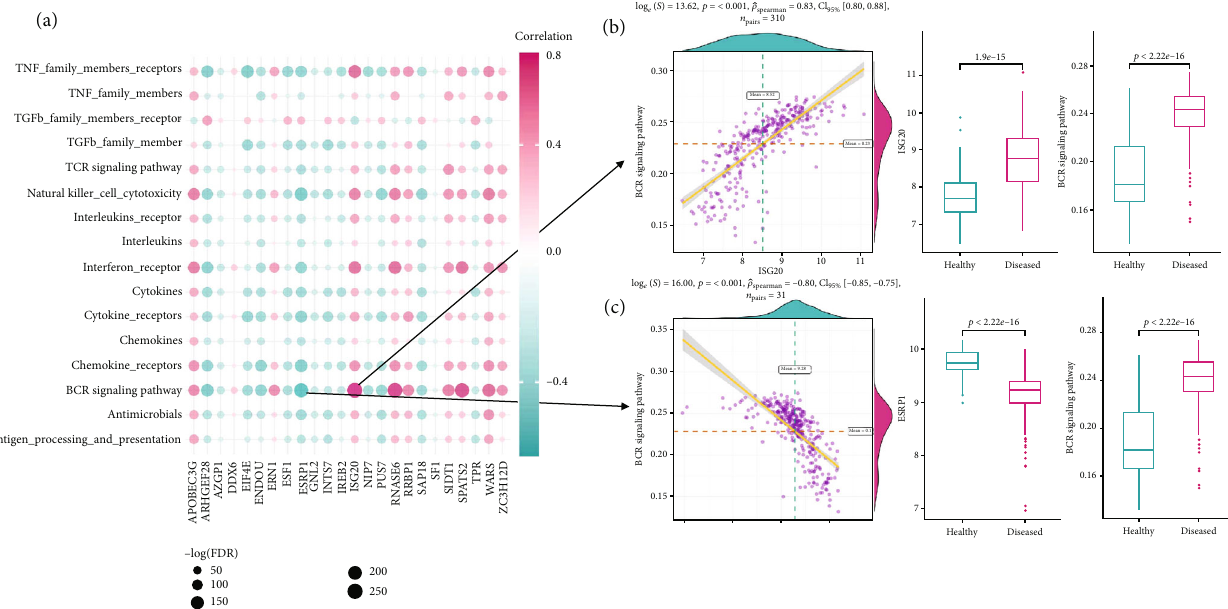
Figure 4: Immune-related pathways in periodontitis and their correlation with RBPs. (a) Correlation analysis between activities of immune pathways and RBPs expression levels. (b) Dot plot and box plot reveal the relationship between the most positively correlated immune pathway-RBP pair, BCR signaling pathway, and ISG20. A higher activity of BCR signaling pathway and higher expression of ISG20 were observed in periodontitis samples. (c) Dot plot and box plot reveal the relationship between the most negatively correlated immune pathway-RBP pair, BCR signaling pathway, and ESRP1. A higher activity of BCR signaling pathway and lower expression of ESRP1 were observed in periodontitis